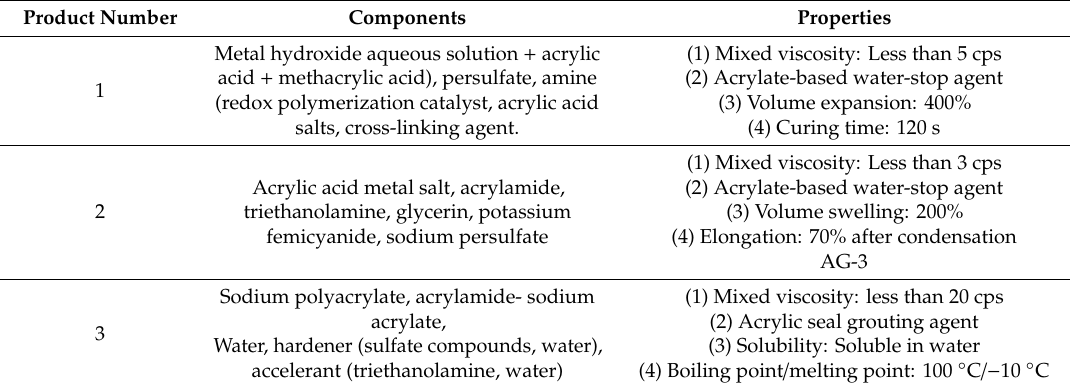
Table 2. The acrylic-resin injection-grout material